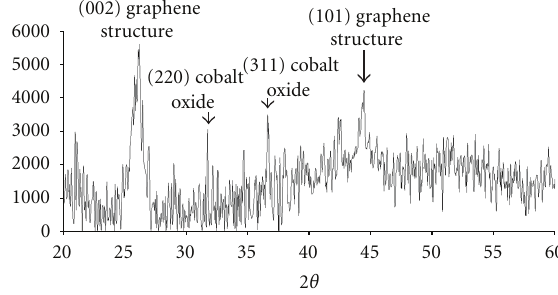
Figure 4: RX di ff raction of carbon